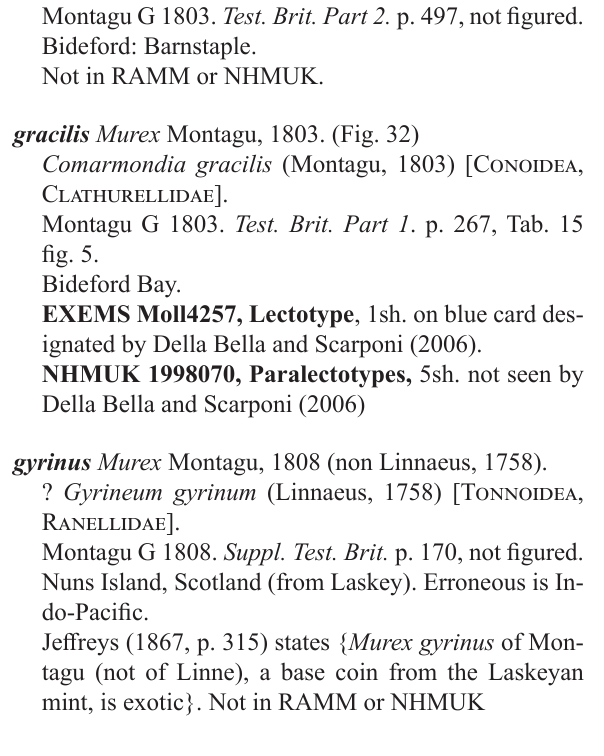
British Channel.